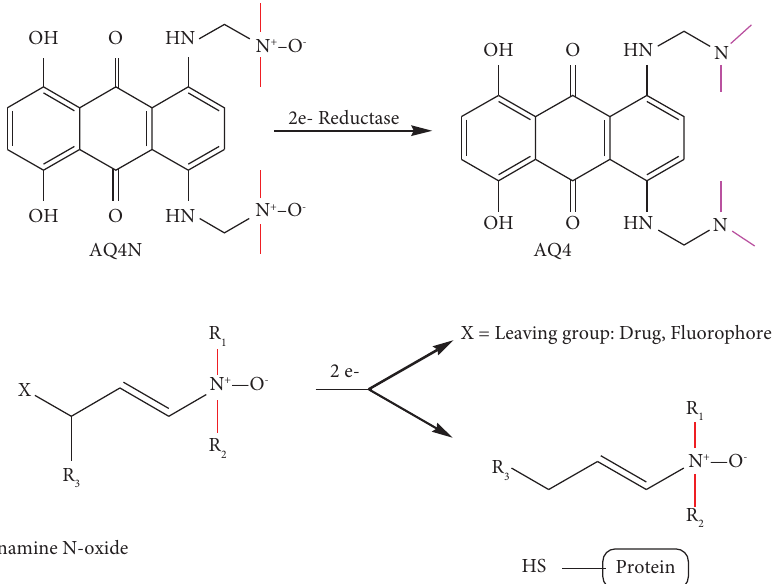
Figure 4: Mechanism of hypoxia-activated AQ4N and enamine N-oxide prodrugs.